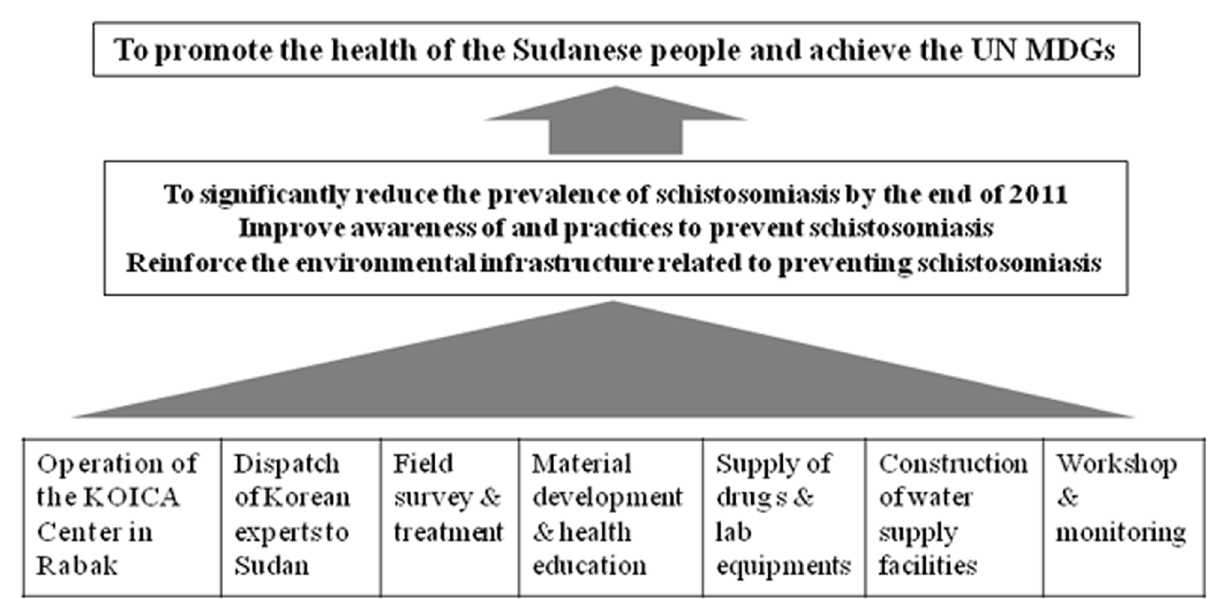
Fig. 1. Flow diagram of "The Project for Combating Schistosomiasis in Sudan 2009–2011." KOICA, Korea International Cooperation Agency. MDG; Millennium Development Goals established following the Millennium Summit of the United Nations in 2000.